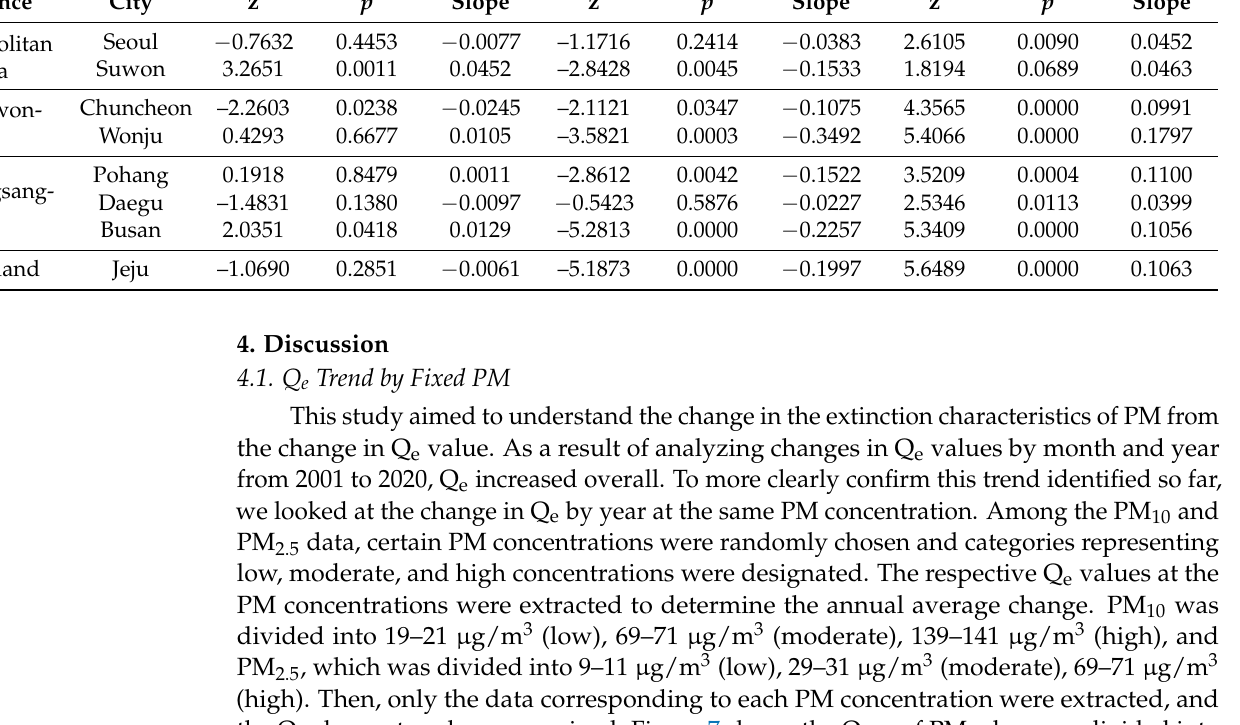
Table 8. Annual Q e trend slope for each concentration category of PM 10 and PM 2.5 based on linear regression analysis.